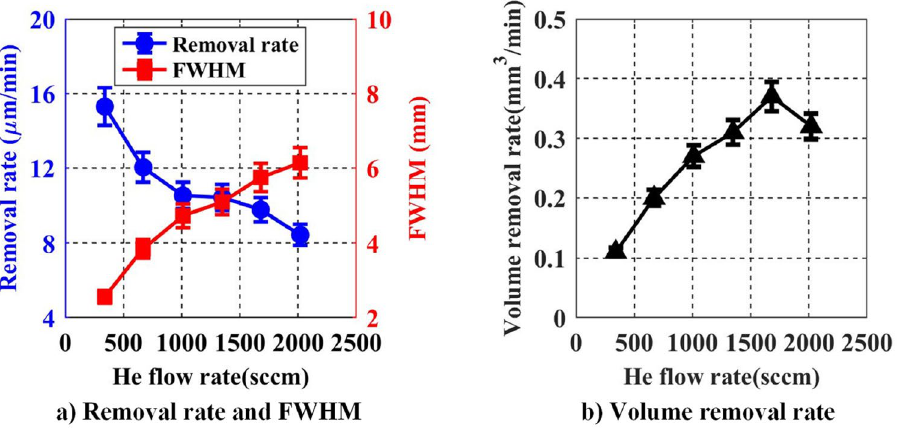
Figure 9. Effect of He flow rate on removal rate and FWHM.